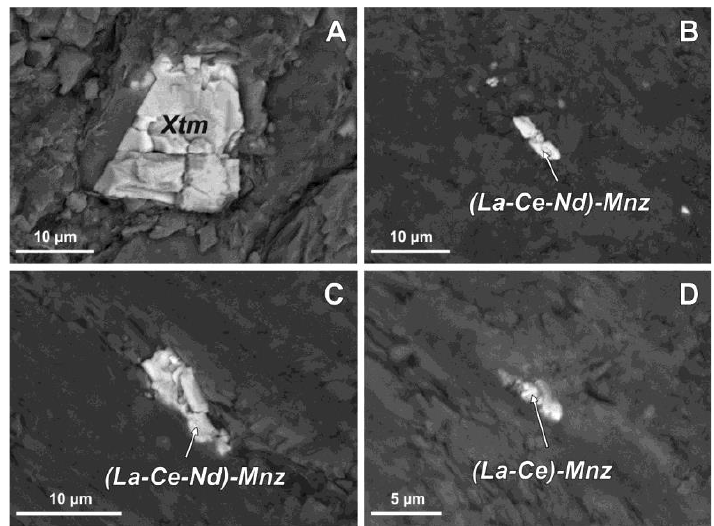
Figure 6. Rare earth element (REE)-bearing minerals in black shale from the Priorat DOQ region. ( A ) Euhedral xenotime (Xtm) crystal. ( B ) Elongated euhedral (La–Ce–Nd)-monazite (Mnz) crystal with 11.67 wt.% La, 17.68 wt.% Ce and 4.66 wt.% Nd. ( C ) Small aggregate of (La–Ce–Nd)-monazite microcrystals (La = 12.88 wt.%; Ce = 25.54 wt.%; Pr = 2.24 wt.%; Nd = 11.61 wt.%; also with 1.11 wt.% Ag and 0.71 wt.% Os). ( D ) Partially disintegrated or chemically abraded euhedral (La–Ce)-monazite microcrystal (La = 15.99 wt.%; Ce = 33.22 wt.%, Pr = 2.89 wt.%; Nd = 11.21 wt.%).